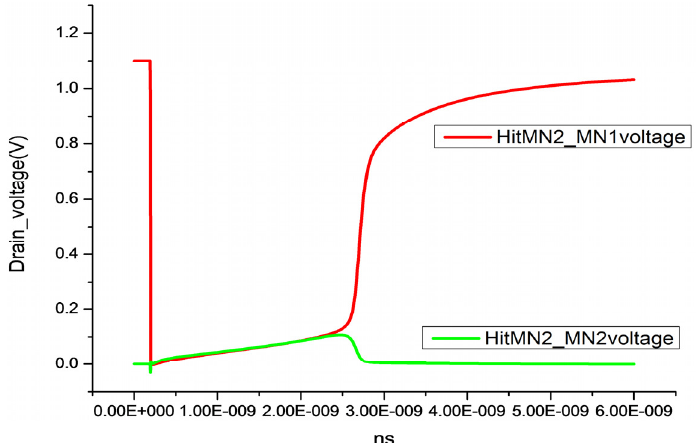
Figure 13. Drain voltage of MN1 and MN2 transistors after the drain central region of the nMOS transistor MN2 is struck with a particle.